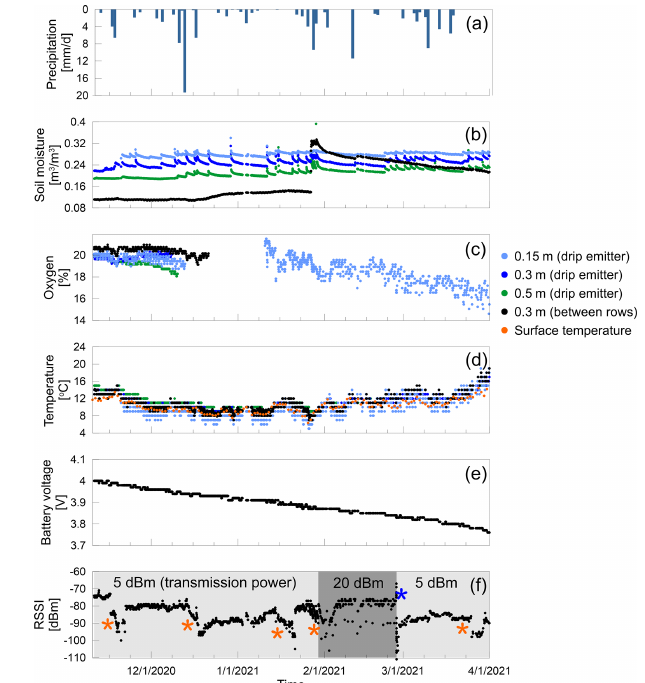
Figure 3. Time series data from the field experiment. Orange as- terisks in plot (f) represent the events during which the received signal strength index (RSSI) decreased markedly. The blue aster- isk in plot (f) indicates the day of the distance test (see Fig. 5). Blank areas in plot (c) are periods of missing data due to sensor malfunctions, as explained in Sect. 3.1. The soil moisture sensor at 0.15m stopped measuring after the initial field installation and was replaced 2 weeks later.